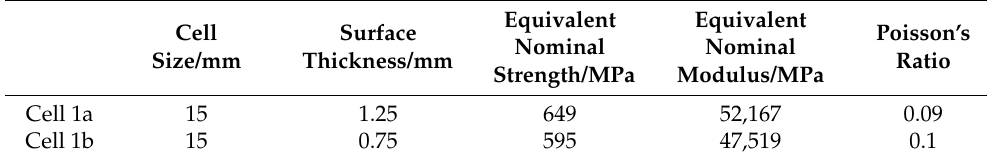
Table 4. Parameters and theoretical properties of unit cell.